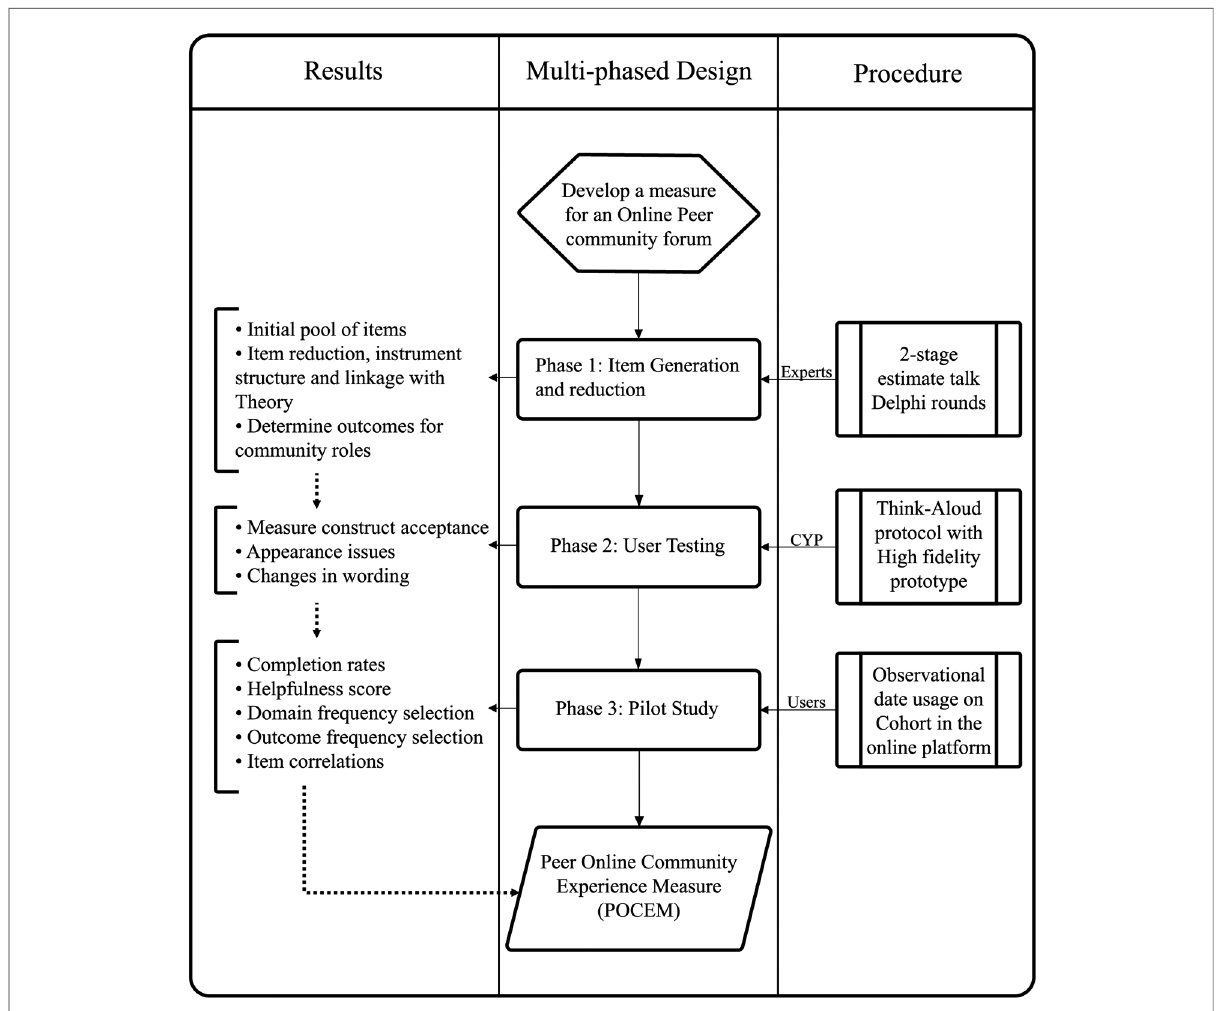
FIGURE 1 Multi-phased design with stakeholders and iterative results in the development of